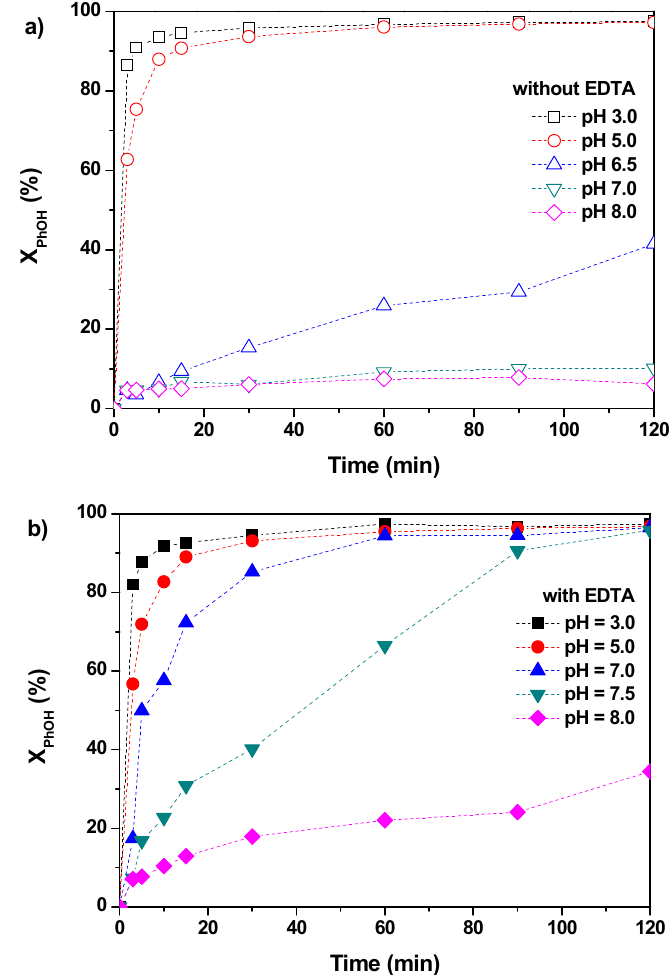
Figure 3. Phenol conversion versus time for different initial pH solution: ( a ) without EDTA (L:M = 0:1), ( b ) with EDTA (L:M = 0.3:1). [Phenol] = 1000 mg/L, [H 2 O 2 ] = 5000 mg/L, [Fe 2+ ] 0 = 7 mg/L, T = 30 °C, and t = 120 min.